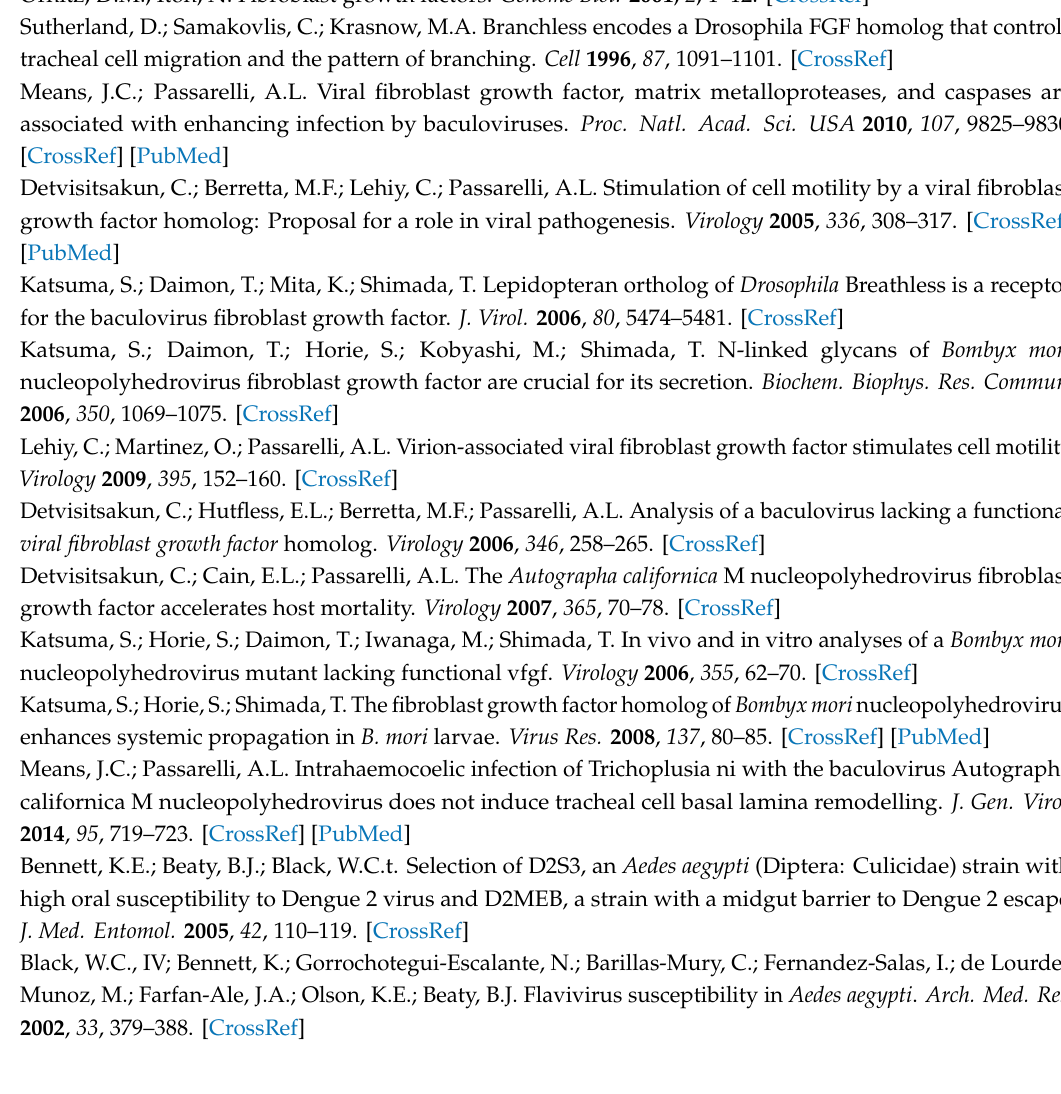
Figure S1: Caspase activity in Aag2 cells infected with TE or TE / vFGF. Figure S2: aspase activity and cell viability of C6 / 36 cells infected with MRE, MRE / vFGF, or MRE / vFGFas. Figure S3: aspase activity in Aag2 cells infected with TE viruses or treated with UV light as a positive control for caspase